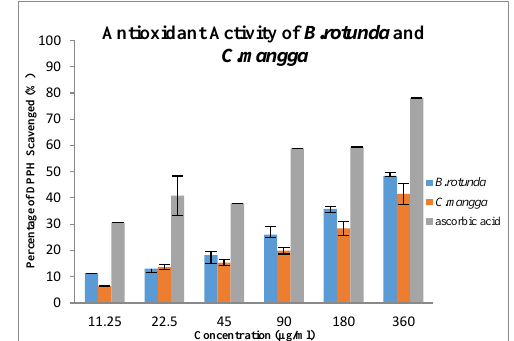
Figure 1: DPPH free radical scavenging activity of B. rotunda, C. mangga